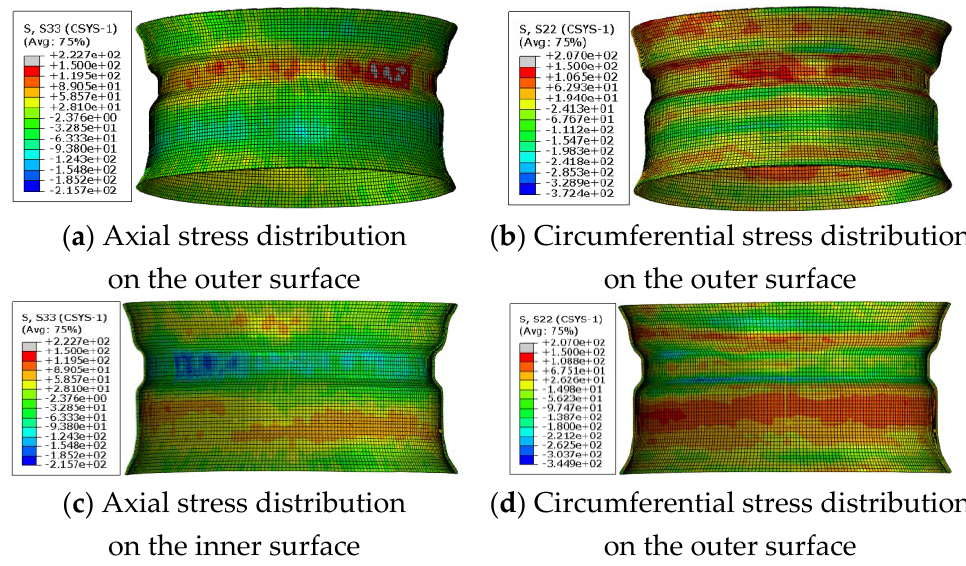
Figure 3. Residual stress distribution after the first rolling.